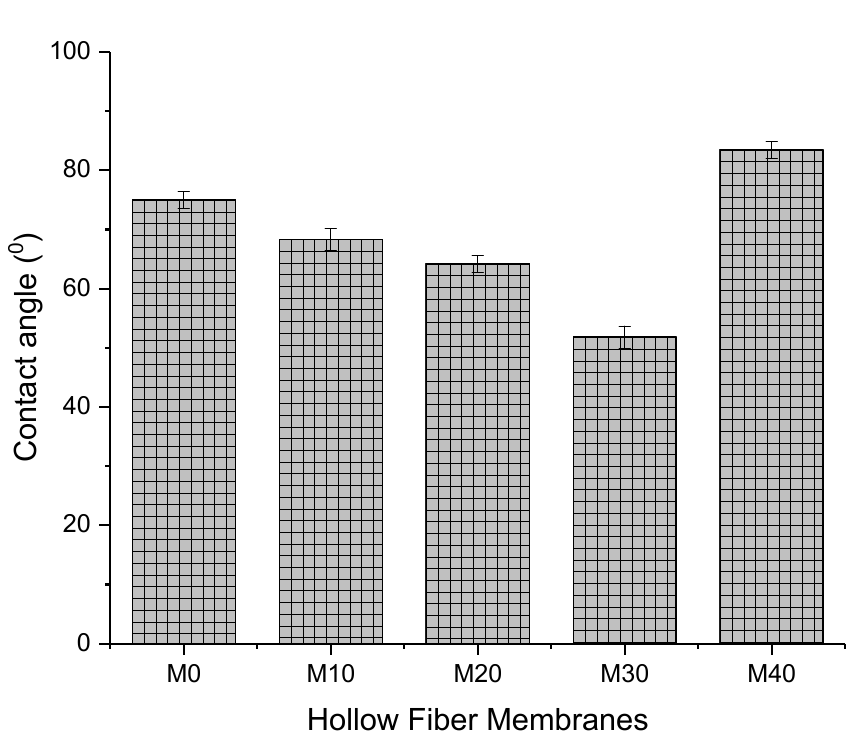
Figure 9. Water contact angle of the membrane outer surface. Error bars indicate standard deviations ( n = 10).